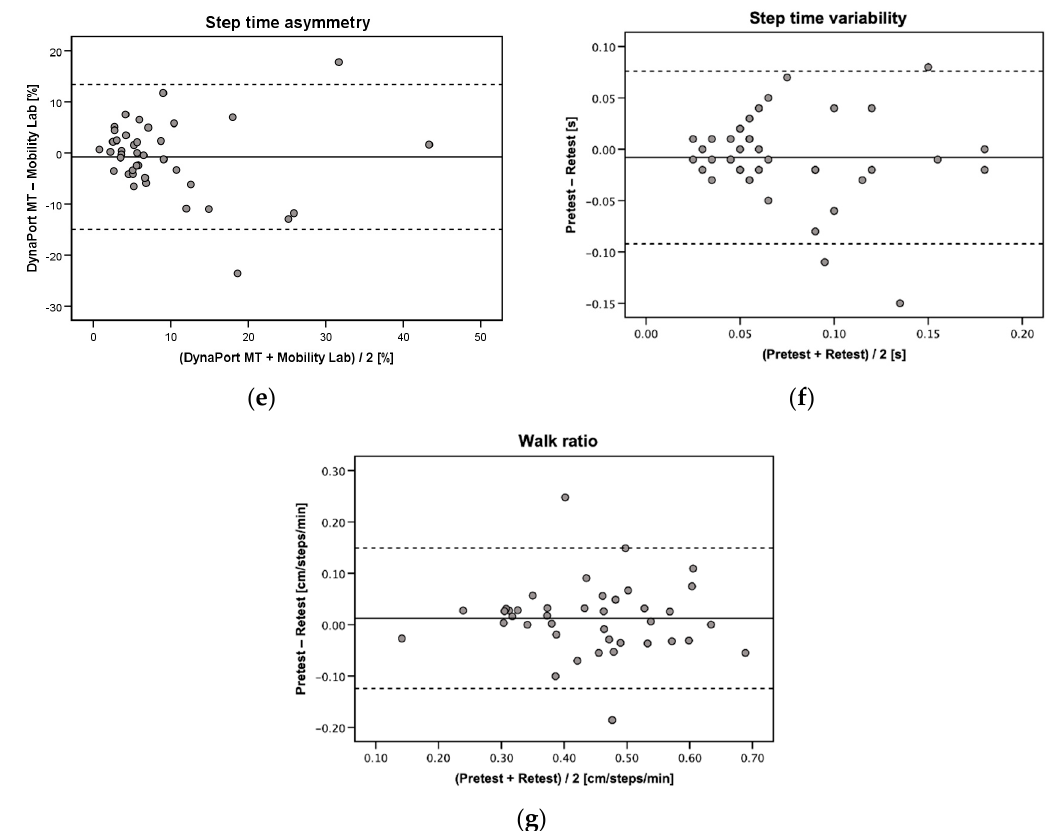
Figure 3. Bland–Altman plots for repeated measurements of ( a ) gait speed, ( b ) cadence, ( c ) step length, ( d ) step time, ( e ) step time asymmetry, ( f ) step time variability, and ( g ) walk ratio with the DynaPort MT (test-retest reliability). Solid lines indicate mean test-retest differences (bias) and dashed lines indicate upper and lower 95% limits of agreement (±1.96 SD of the bias).